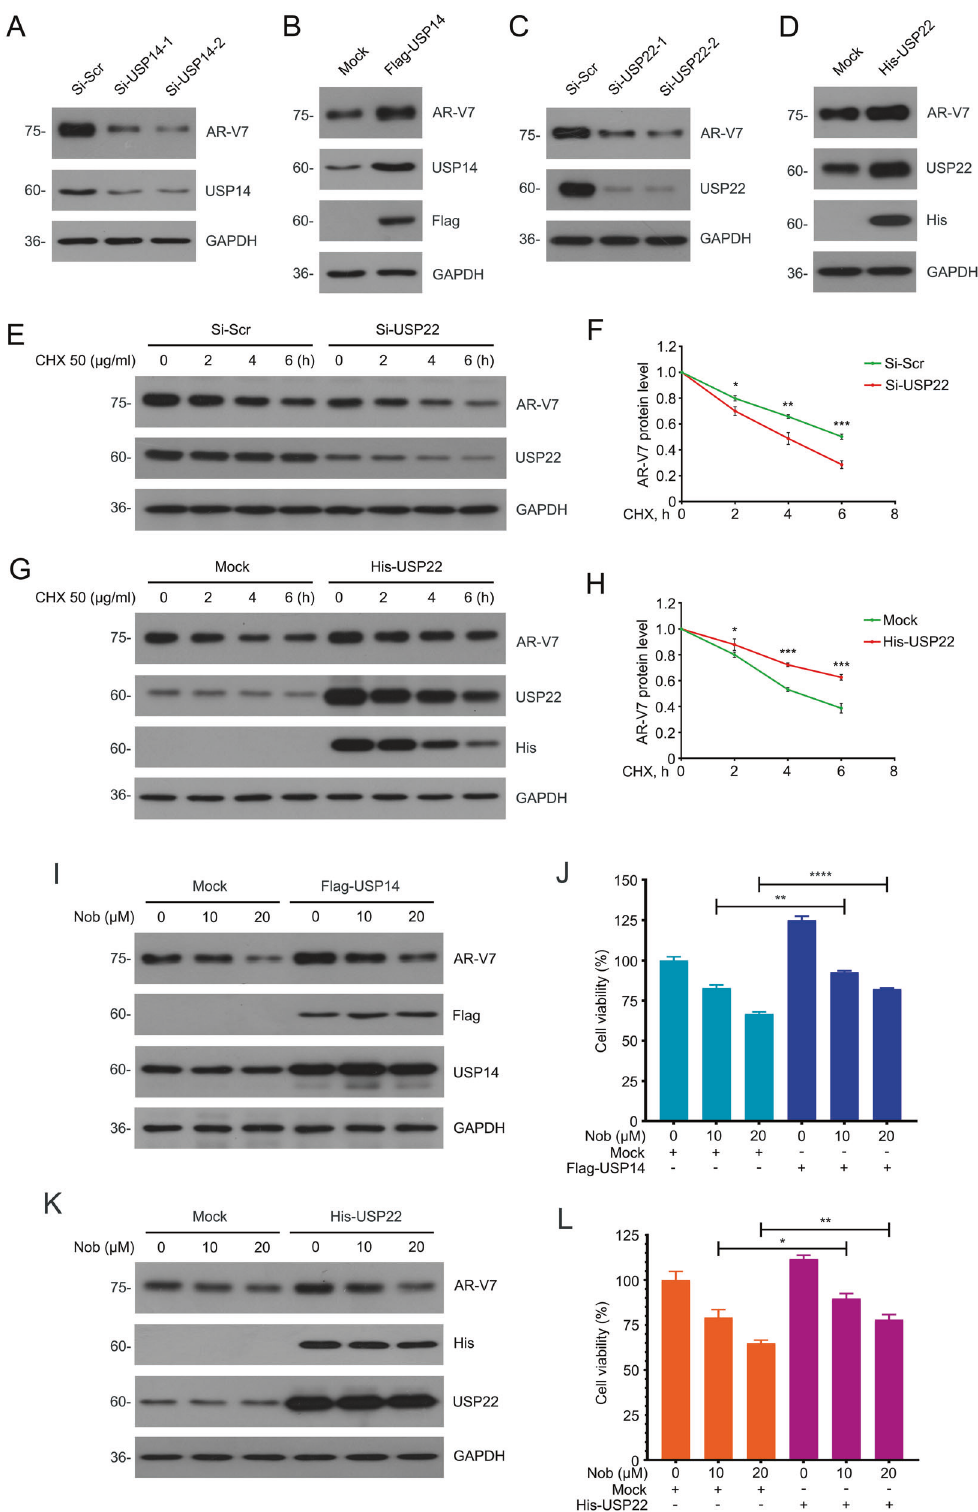
Immunohistochemistry assay further veri fi ed the effect of nobiletin in the downregulation of AR-V7 and Ki67 in vivo (Fig. 6H, I). Moreover, there was no signi fi cant difference in the body weight of the four groups (Fig. 6G). The tissue damage in liver and kidney cannot be observed in mice (Fig. 6J), indicating that the side effects of nobiletin/enzalutamide alone or in combination were low. Cell Death and Disease (2021)